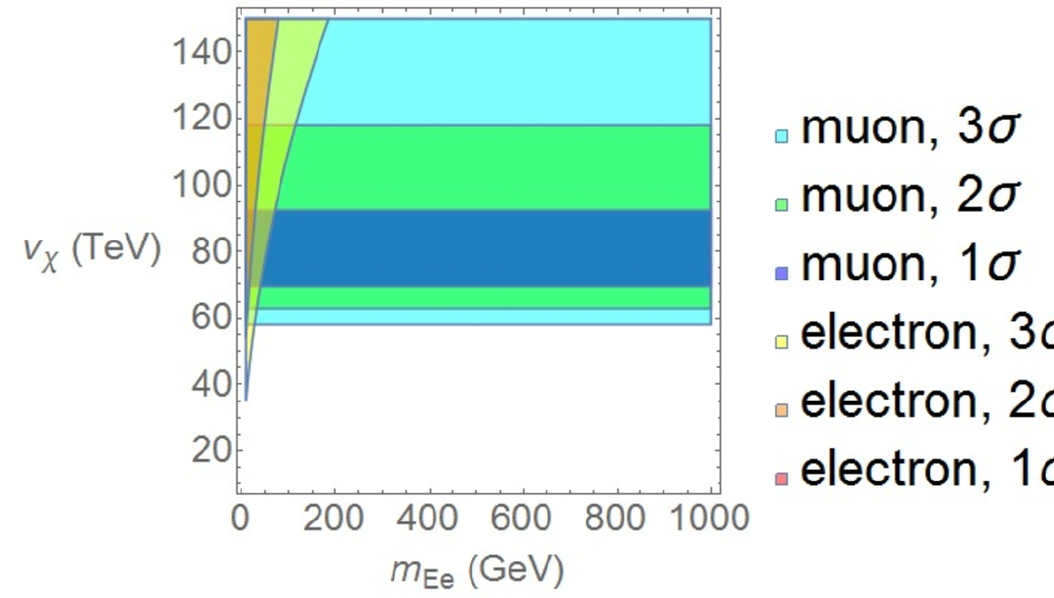
Figure 3 . v (cid:31) and m E values satisfying eq. (3.1) within 1 (cid:27) , 2 (cid:27) and 3 (cid:27) . Here we have used diagonal e mass matrices for the charged leptons (see section 4.2.1) and considered: m E m = 1000, and m = m = m = 1000 (all in GeV). The masses of the exotic gauge A 0 Y ++ Y + 1 Y + 1 bosons ( U (cid:6)(cid:6) and Z 0 ) have their values de(cid:12)ned by the value of v (cid:31) , since its other parameters are already (cid:12)xed (see [37] for